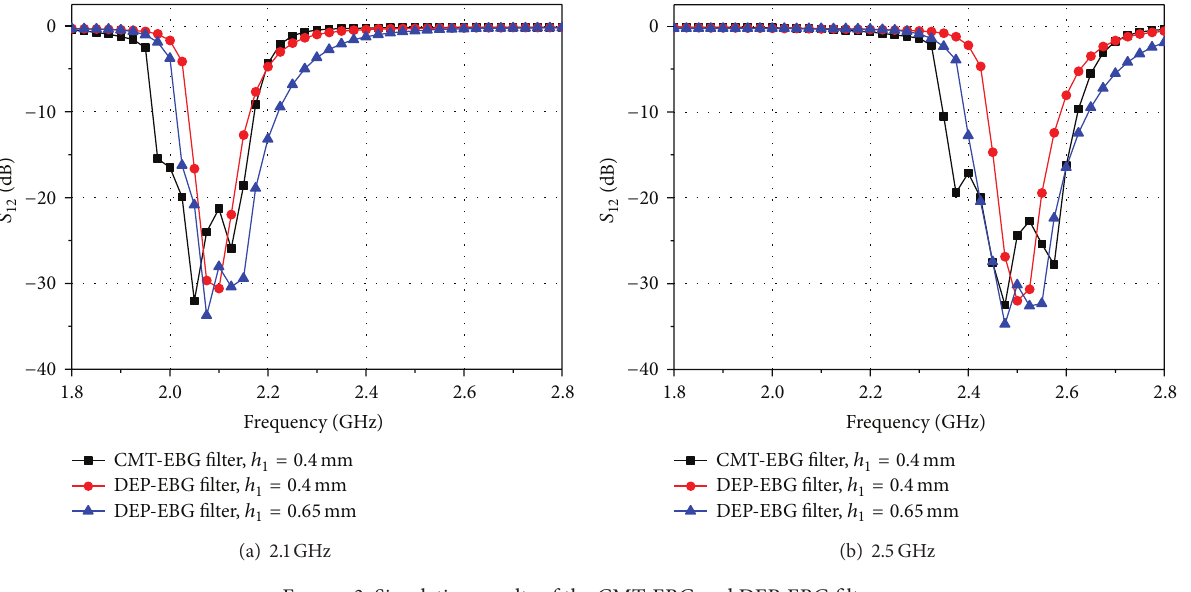
Figure 3: Simulation results of the CMT-EBG and DEP-EBG filters.